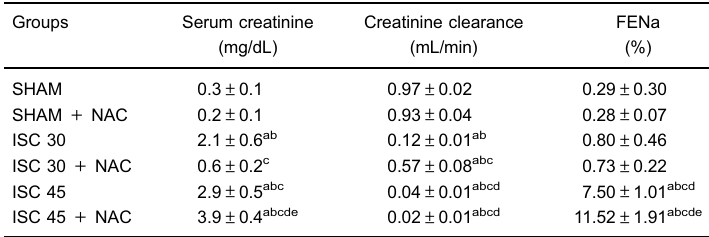
Table 1. Effect of n-acetylcysteine (NAC) treatment on renal function after renal ischemia reperfusion injury. Groups Serum